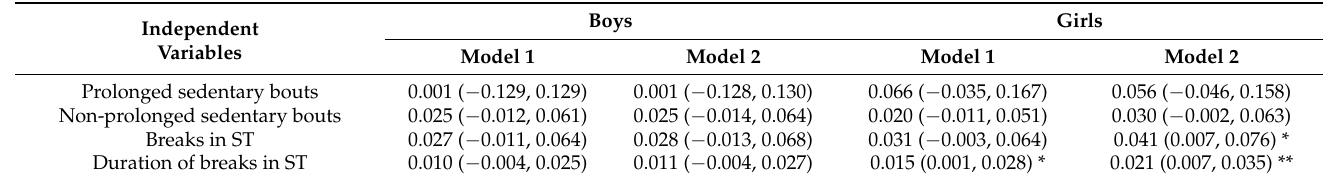
Table 5. Associations between sedentary patterns and CRF in children and